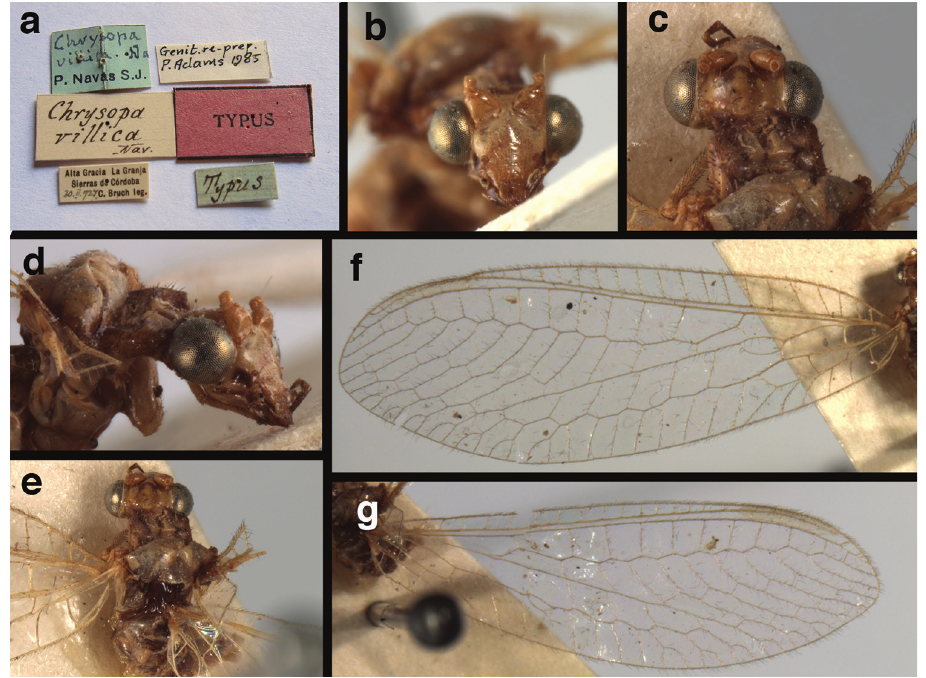
Figure 113. Chrysopa villica Navás: External features, ( a ) labels ( b ) head, frontal ( c ) head, prothorax, dorsal ( d ) head, prothorax, frontolateral ( e ) thorax, dorsal ( f ) forewing ( g ) hindwing (Argentina, Cór- doba, lectotype, male,